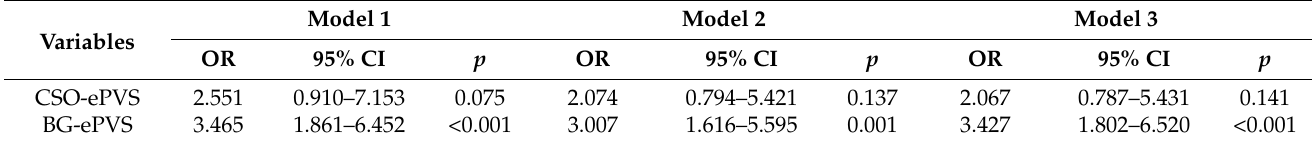
Table 6. Correlation between the severity of ePVS and the presence of